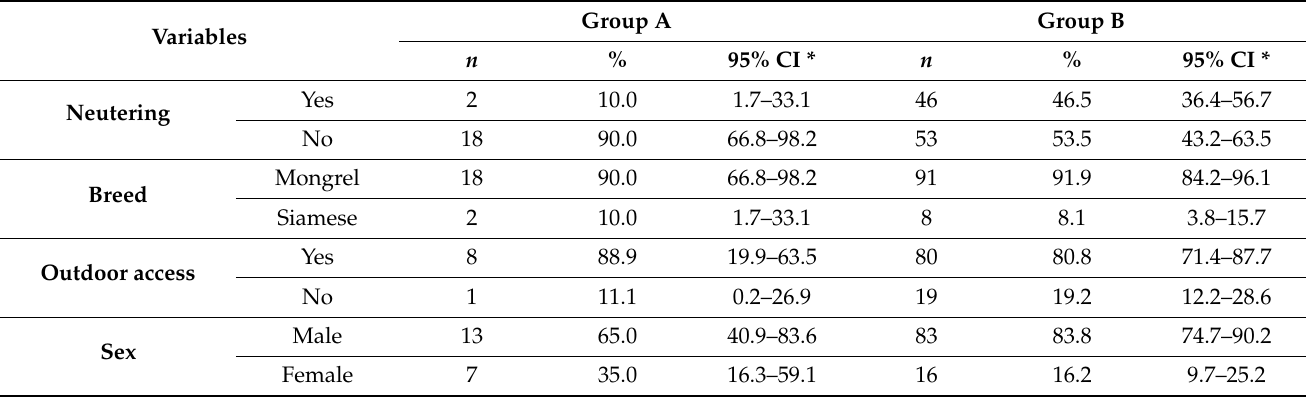
Table 1. Distribution of epidemiological variables of the 119 cats from which the Sporothrix sp. isolates were obtained between 1998 and 2018 (groups A and B), Rio de Janeiro,